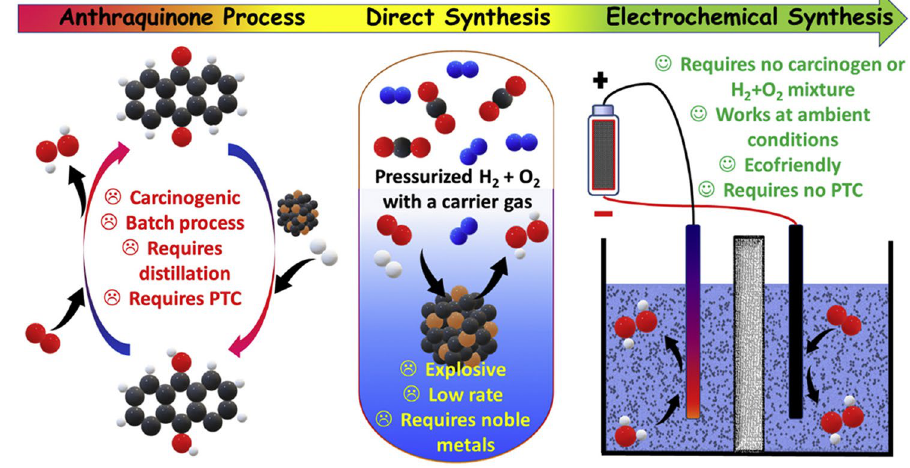
Fig. 1 Schematic of H 2 O 2 production via traditional anthraquinone process, the direct synthesis, and electrochemical synthesis with related demerits and merits. Reprinted with permission [2]. Copyright 2021, Elsevier. (Color figure